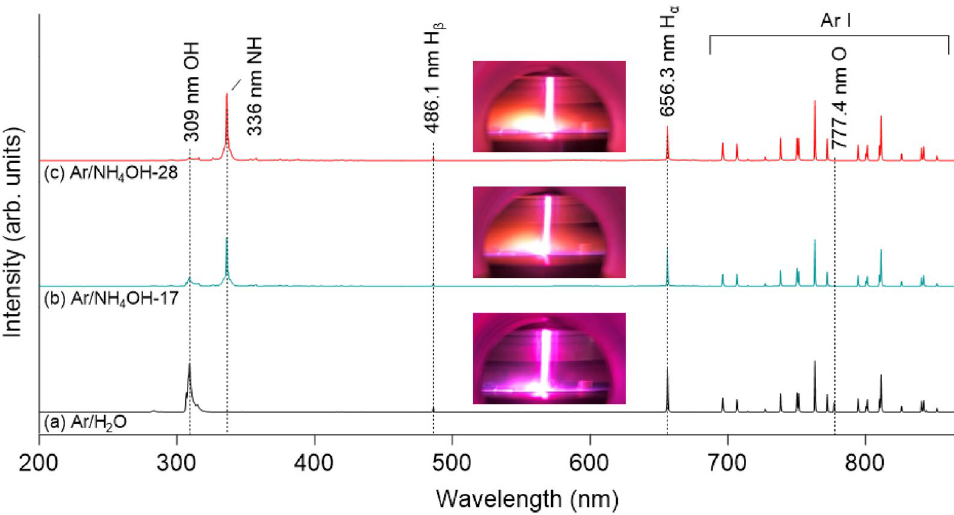
Figure 4. OES of plasmas generated with ( a ) Ar/H 2 O plasma, ( b ) Ar/NH 4 OH-17 plasma, and ( c ) Ar/NH 4 OH- 28 plasma at 100 W and 0.64